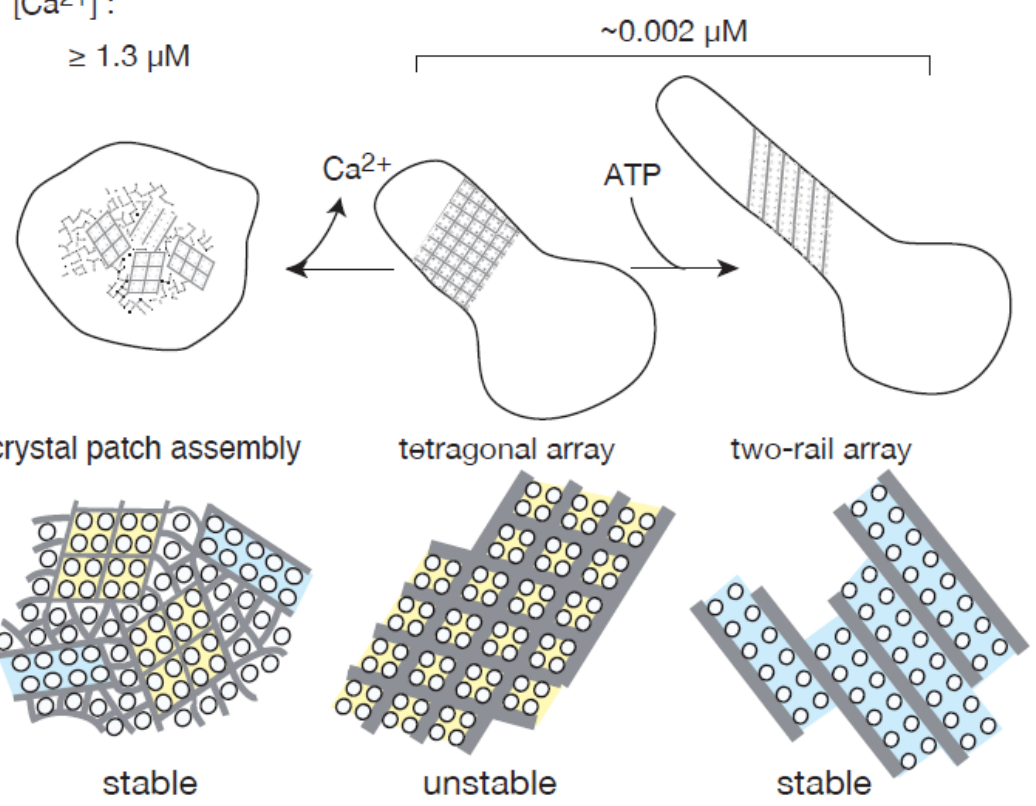
Figure 11. Schematic representation of the formation and development of a crystalline array of Ca 2+ -ATPase molecules in scallop SR. ATP stabilizes the vesicle’s crystalline array to elongate the vesicle.